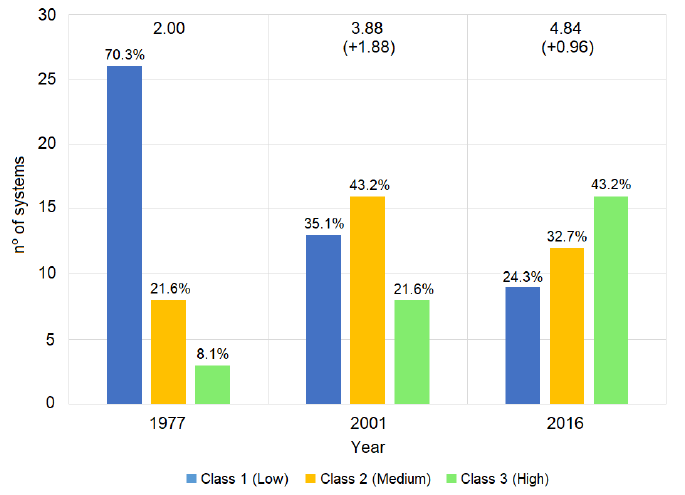
Figure 9. Fragmentation Index. The number on top of histograms represents the total value of fragmentation per year and in brackets is the increment recorded among successive periods.